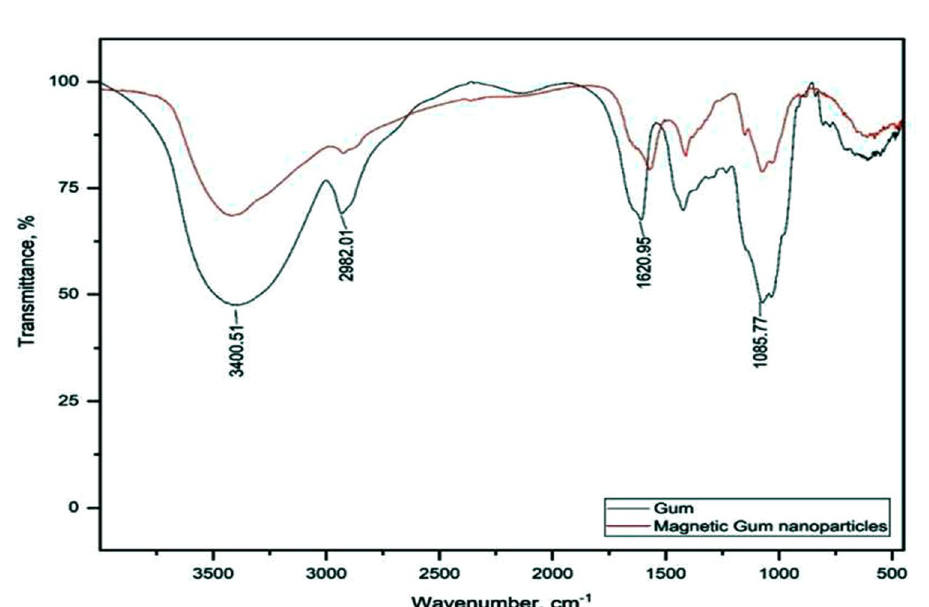
Figure 2. FTIR spectra for GA and magnetic GA linked with chitosan